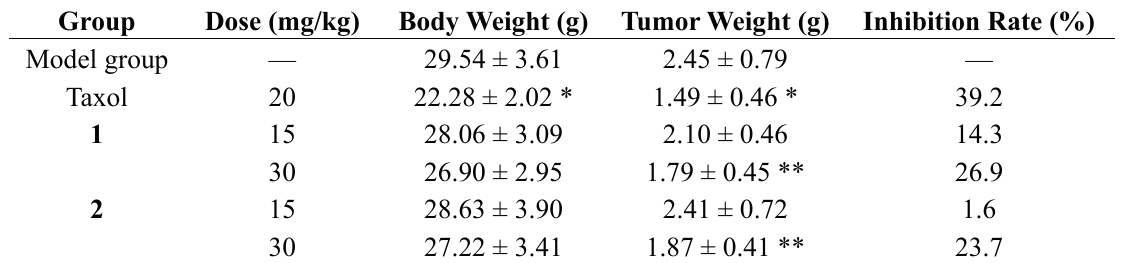
Table 3. Inhibitory effect of 1 and 2 on the S180 tumor growth in mice (mean ± S.D., n = 8 or 11). Group Dose (mg/kg) Body Weight (g) Tumor Weight